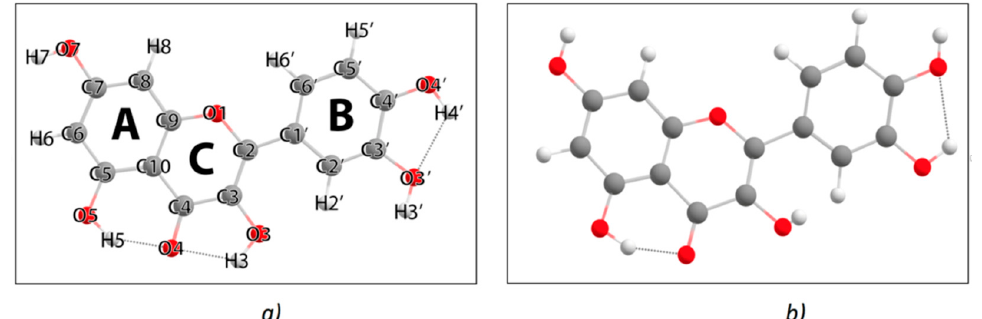
Figure 4. ( a ) Structure of the quercetin molecule (Q_M enol form). The orientations of hydroxyl groups and position of B-ring correspond to the global minimum (M06-2X/6-31++G(d,p)) in vacuum. The numbering of the atoms is also shown. ( b ) Q molecule conformer found in crystal structures of anhydrous Q crystal (Q_A enol form).